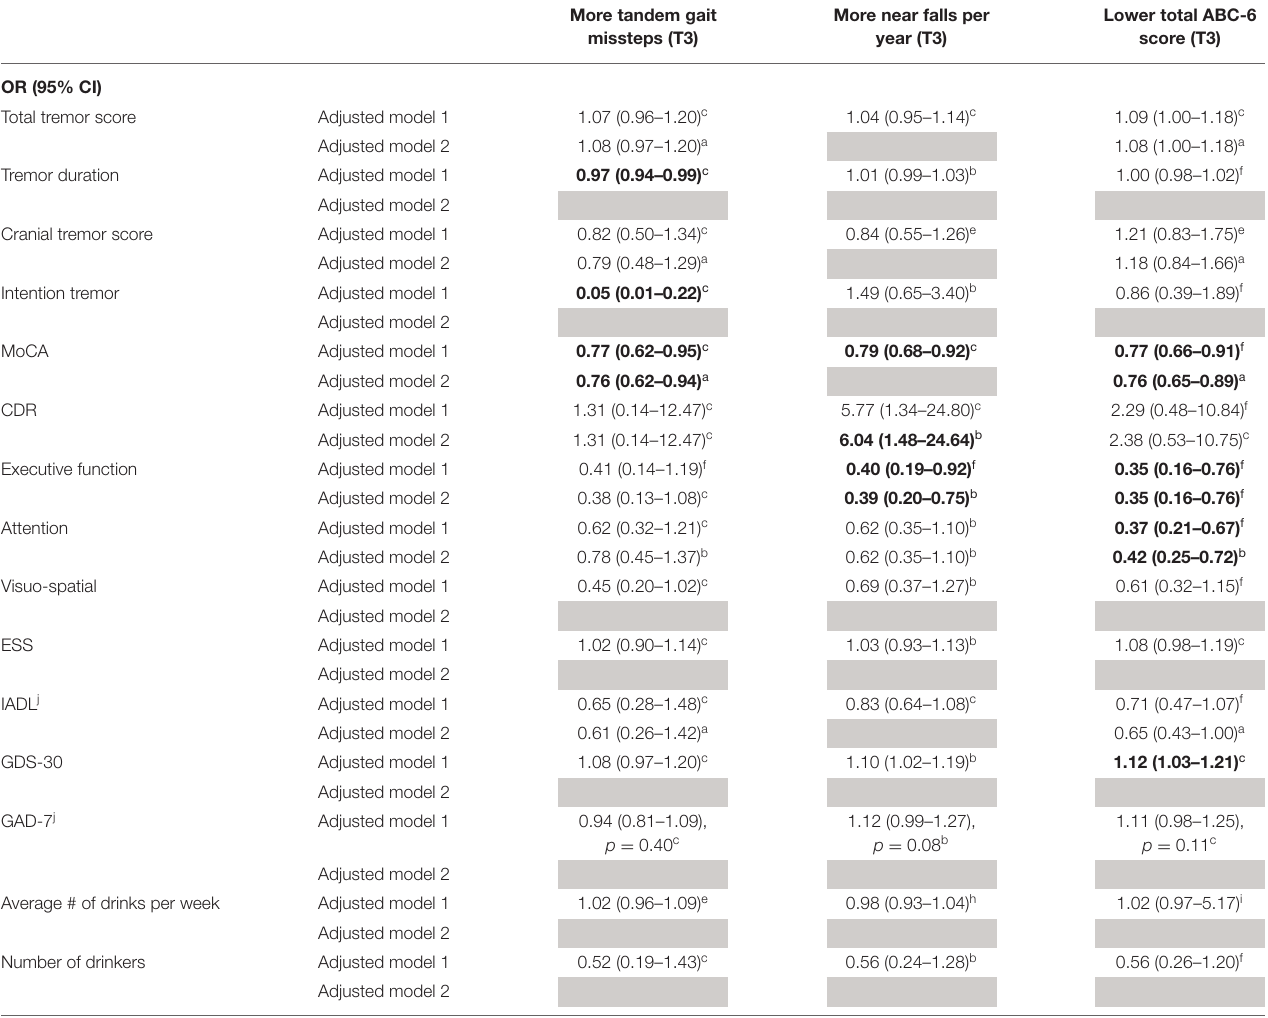
TABLE 4C | Adjusted logistic regression models: Baseline characteristics as predictors of T3 gait and balance outcomes (based on available